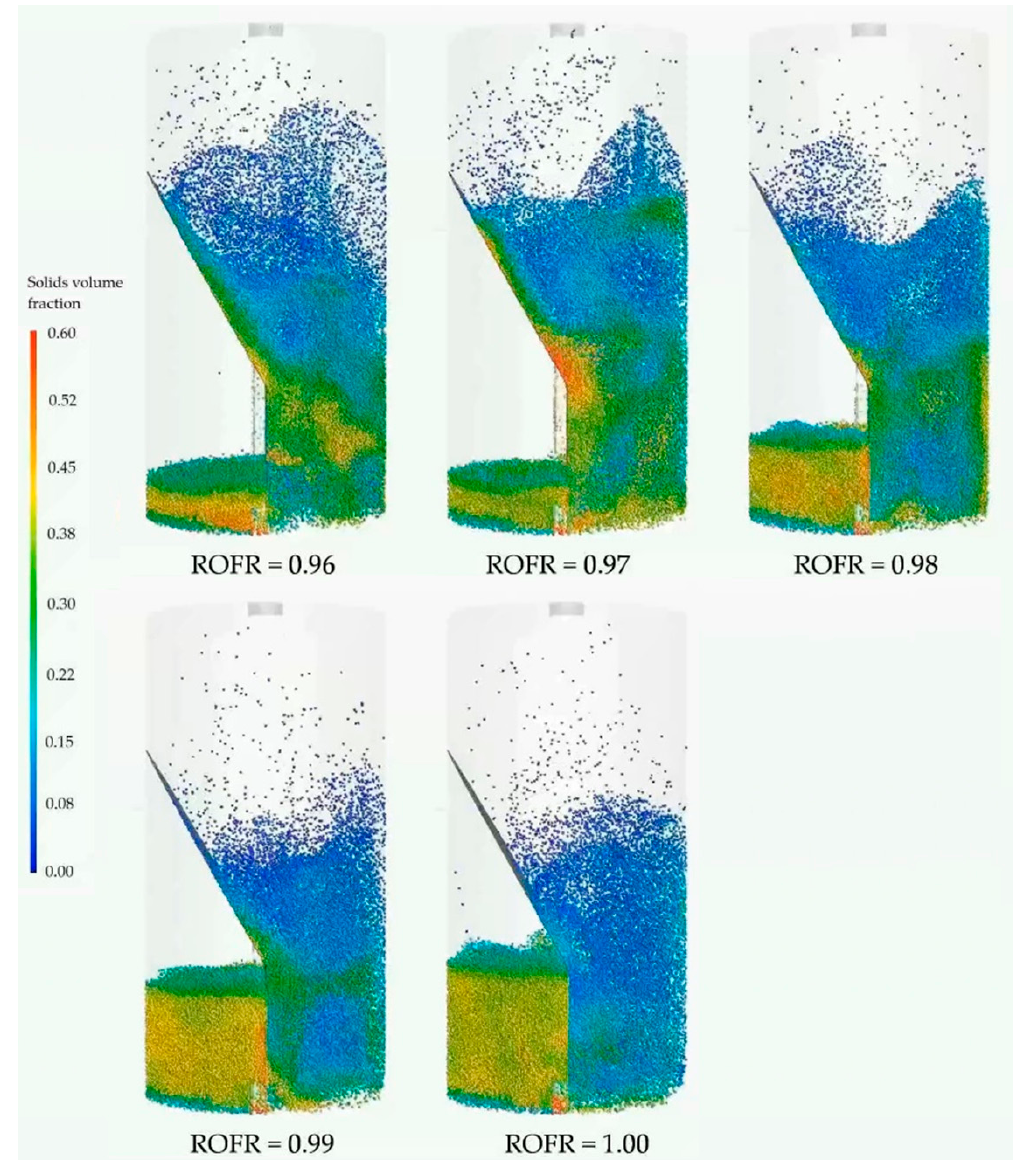
Figure 7. Instantaneous particle plot of the cases with varying reduction outlet flow ratios, where the particles are colored by the particle volume fraction. A corresponding animation is provided in Video S3. Note that the particles pictured are tracers following the continuous solids flow for visualization purposes and do not influence the simulation solution.